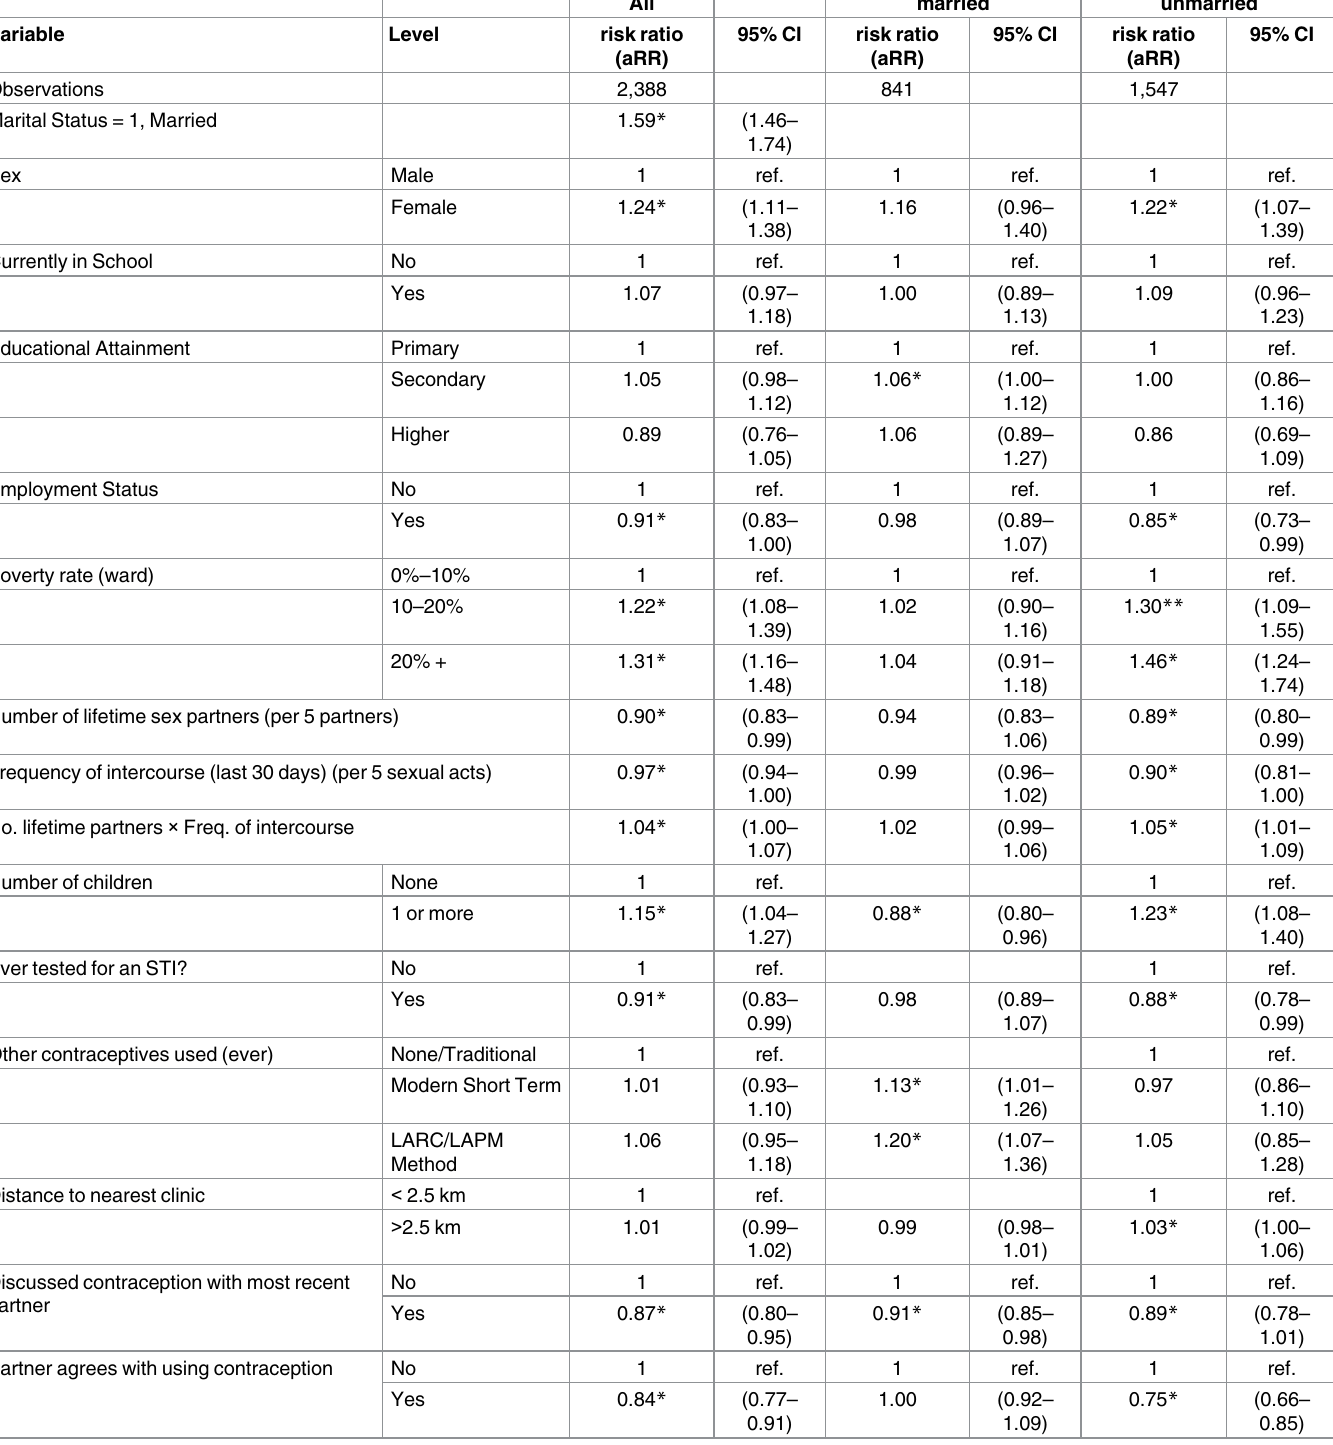
Table 4. Factors (from stage 4 model) associated with non-use of male condoms, stratified by marital status. All